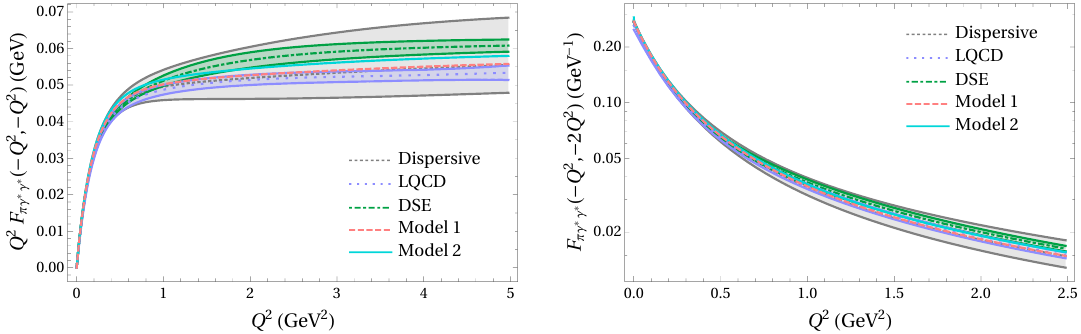
= Q 2 = Q 2 (left) and in the region 1 2